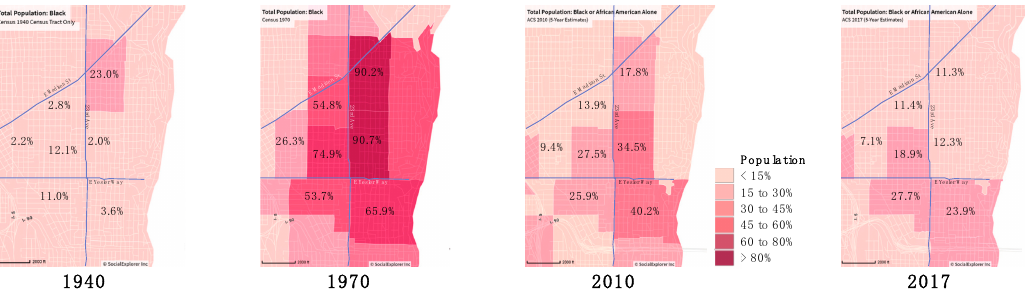
Figure 3. Central District population identifying as Black or African American. Source: Cheryl Klotz, data from Social Explorer.